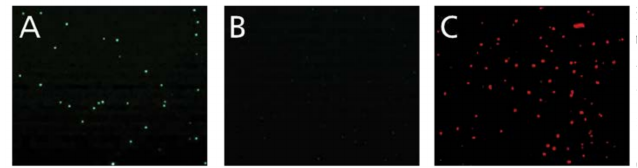
Figure 1. Calcein staining permits selective detection of live, but not of dead target cells. Live calcein-stained K562 cells (green) are shown in ( A ). The image has been acquired by an ImmunoSpot ® S6 FluoroCore Reader with the cells present in 100 µ L culture medium in a 96 well flat bottom plate. ( B ) The same number of dead (ethanol-exposed) K562 cells has been plated with no calcein-stained cells detectable. ( C ) As in B, but PI was added to stain dead cells. Based on the notion that dead target cells lose their calcein staining, we started to perform Calcein TVAs that were set up in an analogous fashion to traditional 51 Cr release assays (CRA), incubating effector and target cells at various ratios, after which calcein-stained target cells were counted instead of 51 Cr release measured. Figure 2 illustrates such an experiment. In this experiment, a decreasing number of effector cells (PBMC) are plated together with a constant number of calcein-labeled K562 target cells (4000 per well) resulting in effector: target (E:T) ratios ranging from 100:1 to 12.5:1. Effectors and targets are co-cultured for 4 h, after which 3 × 50 µ L of the cell suspension present in each well of the original U bottom assay plate are transferred into a 96 well flat bottom plates for imaging and counting. Wells containing target cells with medium only, thus without effector cells, constitute the assay blank, or negative control. In the experiment shown in Figure 2, 954 cells were counted in the blank well: as ~4000 Calcein-labeled K562 cells were present in 200 µ L in the original round bottom plate, of which one fourth were transferred 50 µ L, theoretically 1000 labeled cells should be present in the imaged well. With 954 labeled cells actually counted, we can conclude that (a) essentially all cells K562 cells were labeled; (b) have been transferred; and (c) counted.